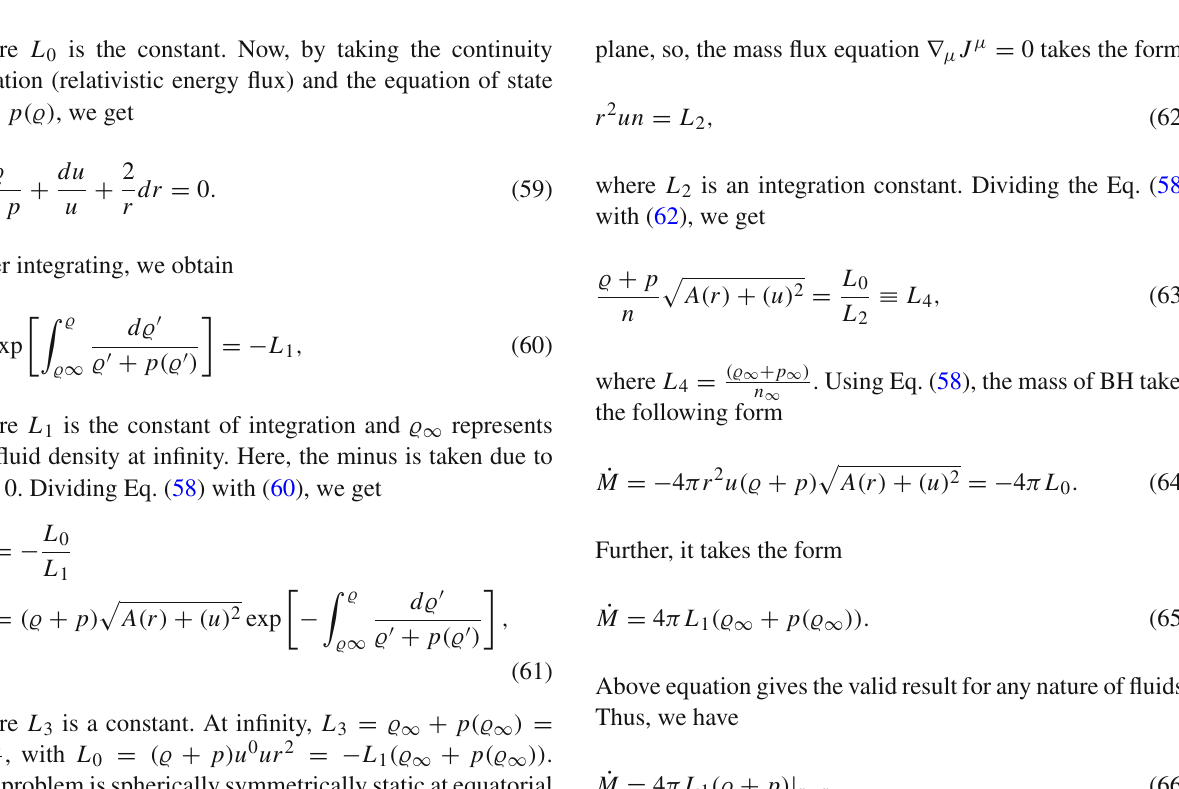
Fig. 7 For the polytropic fluid accretion, left panel (conformal gravity BH) displays the behavior of (53). Right panel (Schwarzschild–de Sitter BH) displays the behavior of (54). Bottom panel (Schwarzschild BH) displays the behavior of